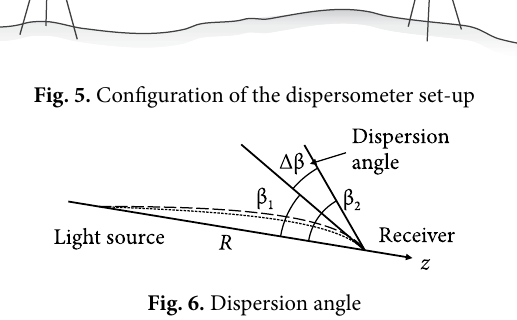
Fig. 6. Dispersion